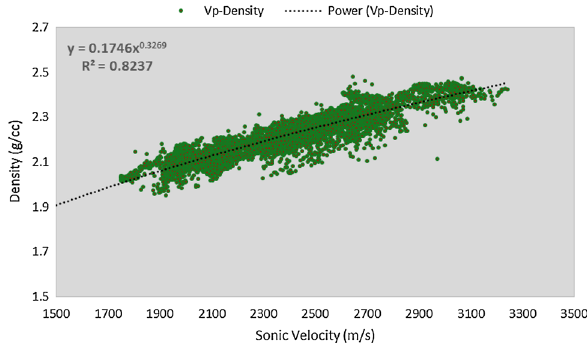
Fig. 4 Vp–density empirical relationship for the location (calibrated Gardner equation)